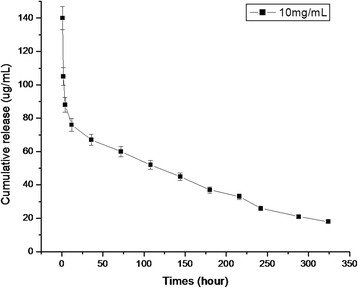
Cumulative release kinetics of PCV2 GST-ORF2-E protein from HMSNs in PBS at pH 7.0.